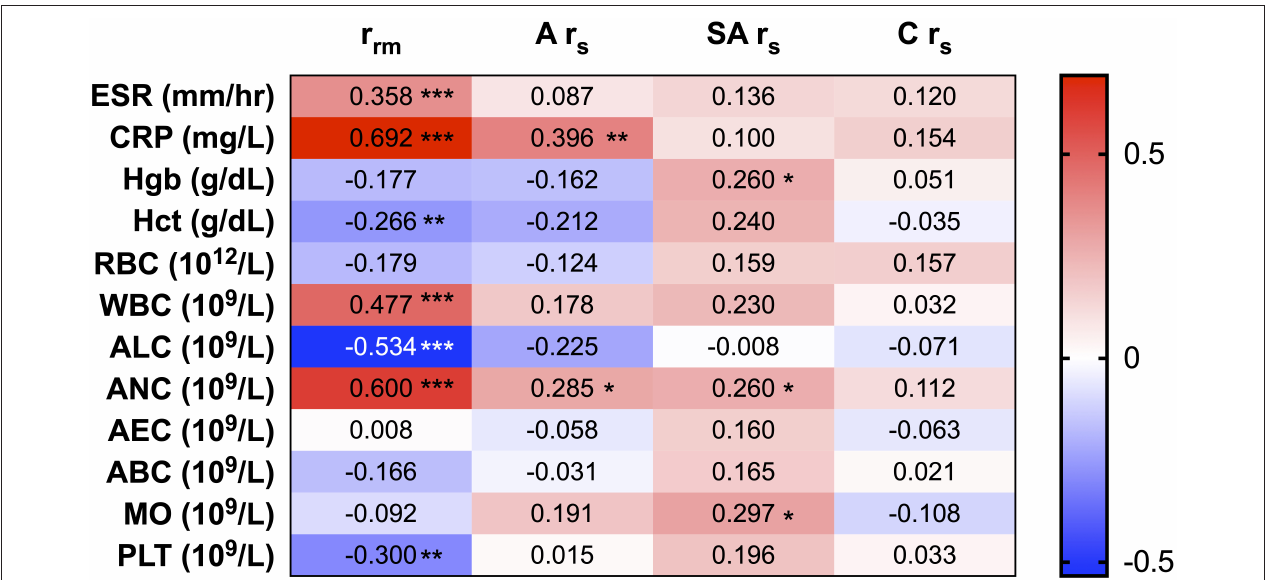
FIGURE 3 | Correlations between PTX-3 and clinical measures of inflammation (i.e., C-reactive protein, erythrocyte sedimentation rate, and complete blood count). The number in each cell in the heat map indicates the repeated-measures correlation analysis ( r rm ) between PTX-3 and the clinical laboratory parameters of inflammation at all phases of Kawasaki disease (KD) and Spearman’s correlation ( r s ) analysis between PTX-3 and the clinical laboratory parameters of inflammation at the acute (A r s ), sub-acute (SA r s ), and convalescent (C r s ) phases of KD. The red cells show positive correlations and the blue cells show negative correlations. * p ≤ 0.05; ** p ≤ 0.01; *** p ≤ 0.001.